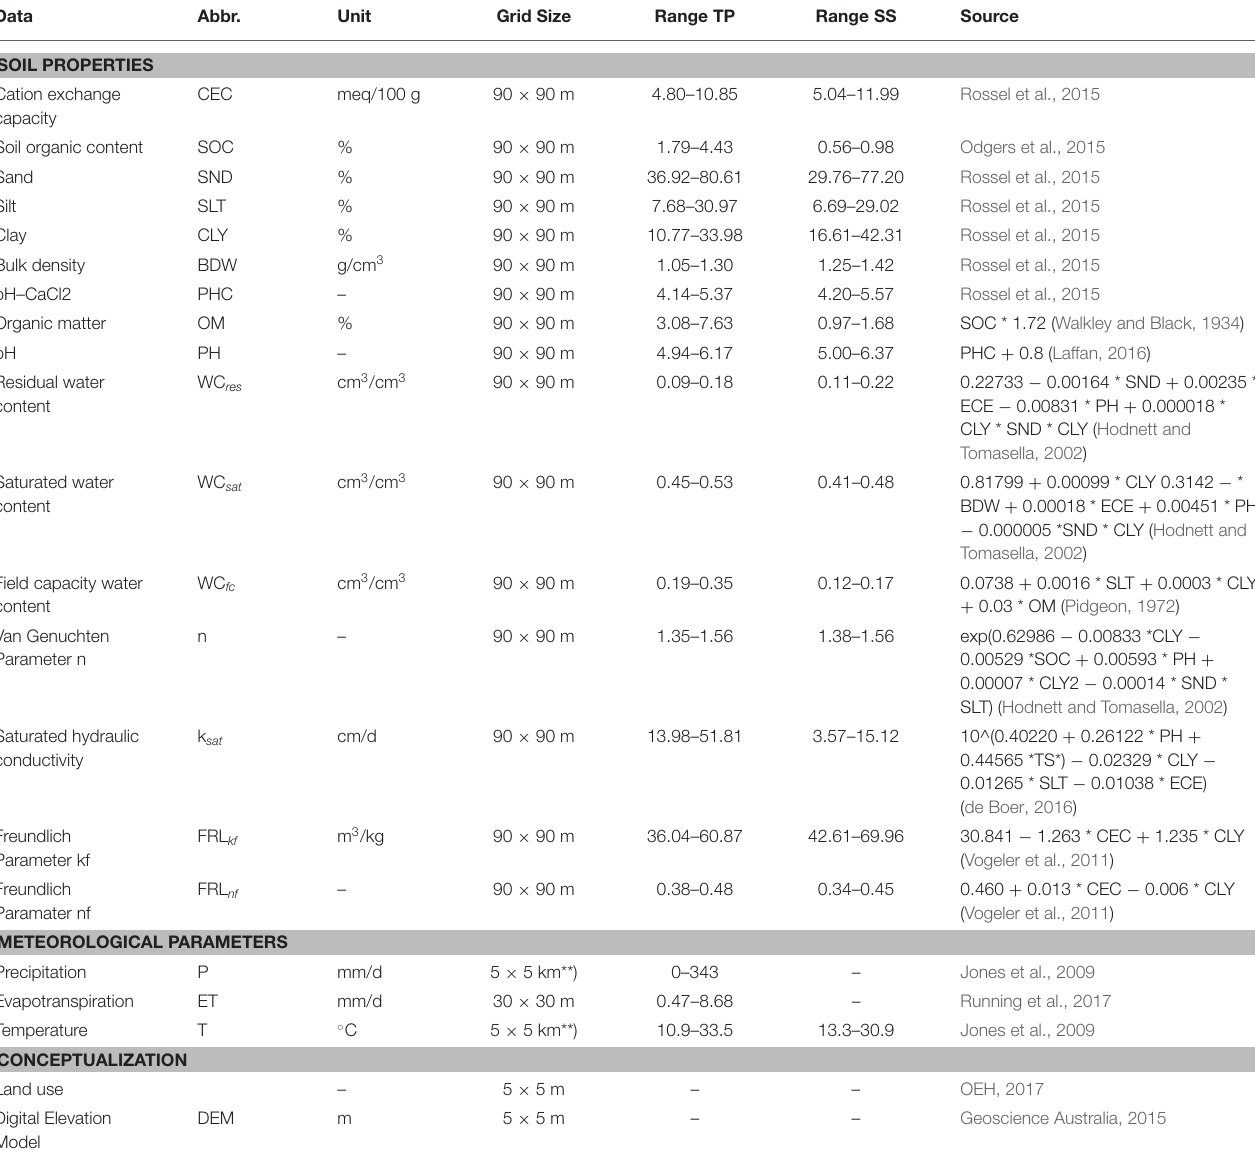
TABLE 1 | Abbreviations (Abbr.), unit, grid size, data ranges from 0.3 m topsoil (TS) and 0.7 m subsoil (SS) and sources from soil, meteorological and conceptualization data used for the